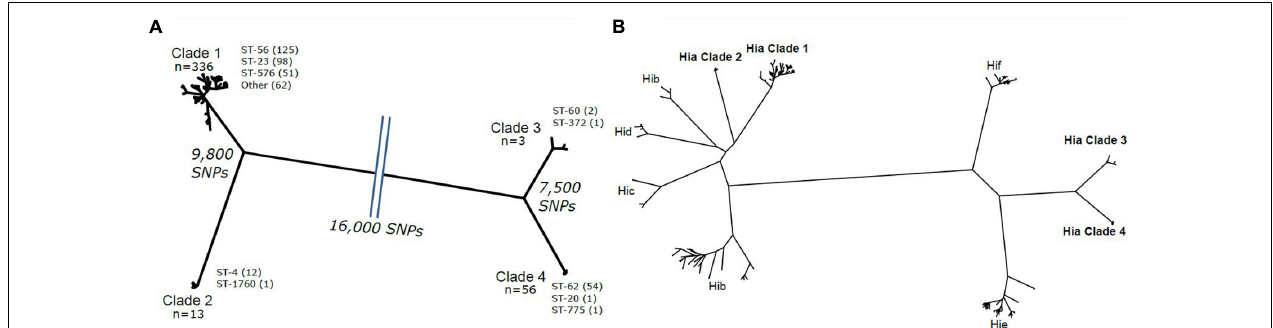
FIGURE 1 | (A) Phylogeny showing the phylogenetic structure of the Hia isolates. Each clade is marked with the number of isolates and the major sequence types and their counts. The SNP difference between each clade is shown. (B) The phylogeny is shown including all Hia isolates and the additional encapsulated serotypes. The four Hia clades are shown in